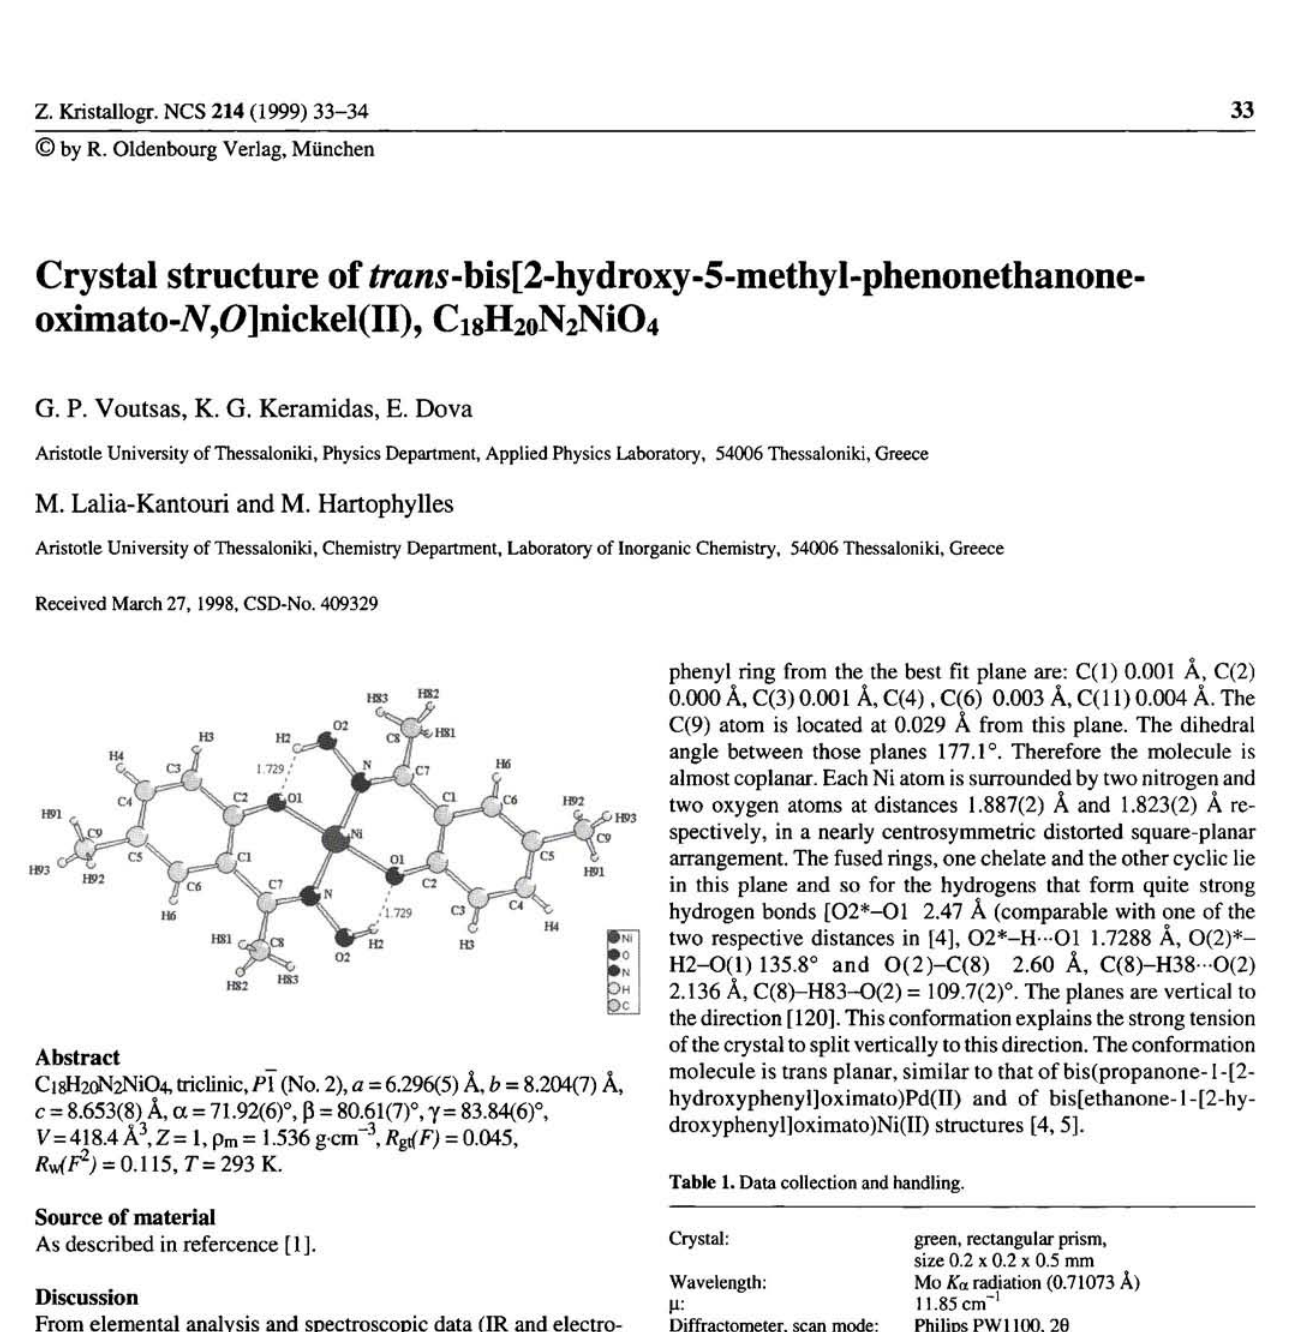
Table 2. Atomic coordinates and displacement parameters (in Â 2